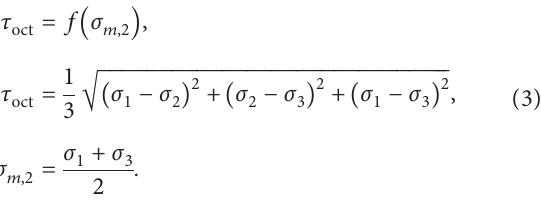
� 5MPa. (b) σ . (a) σ 2 2